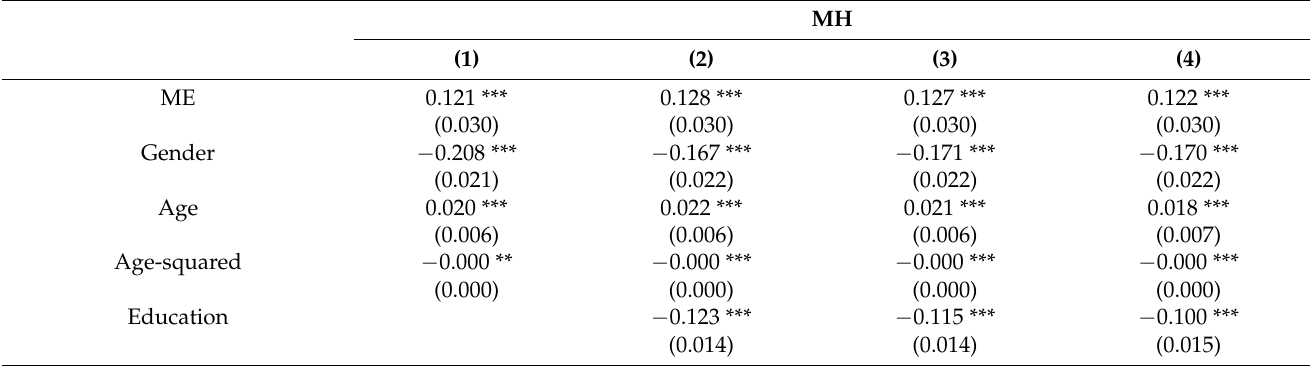
Table 2. Baseline result for the impact of migration experience on rural residents’ mental